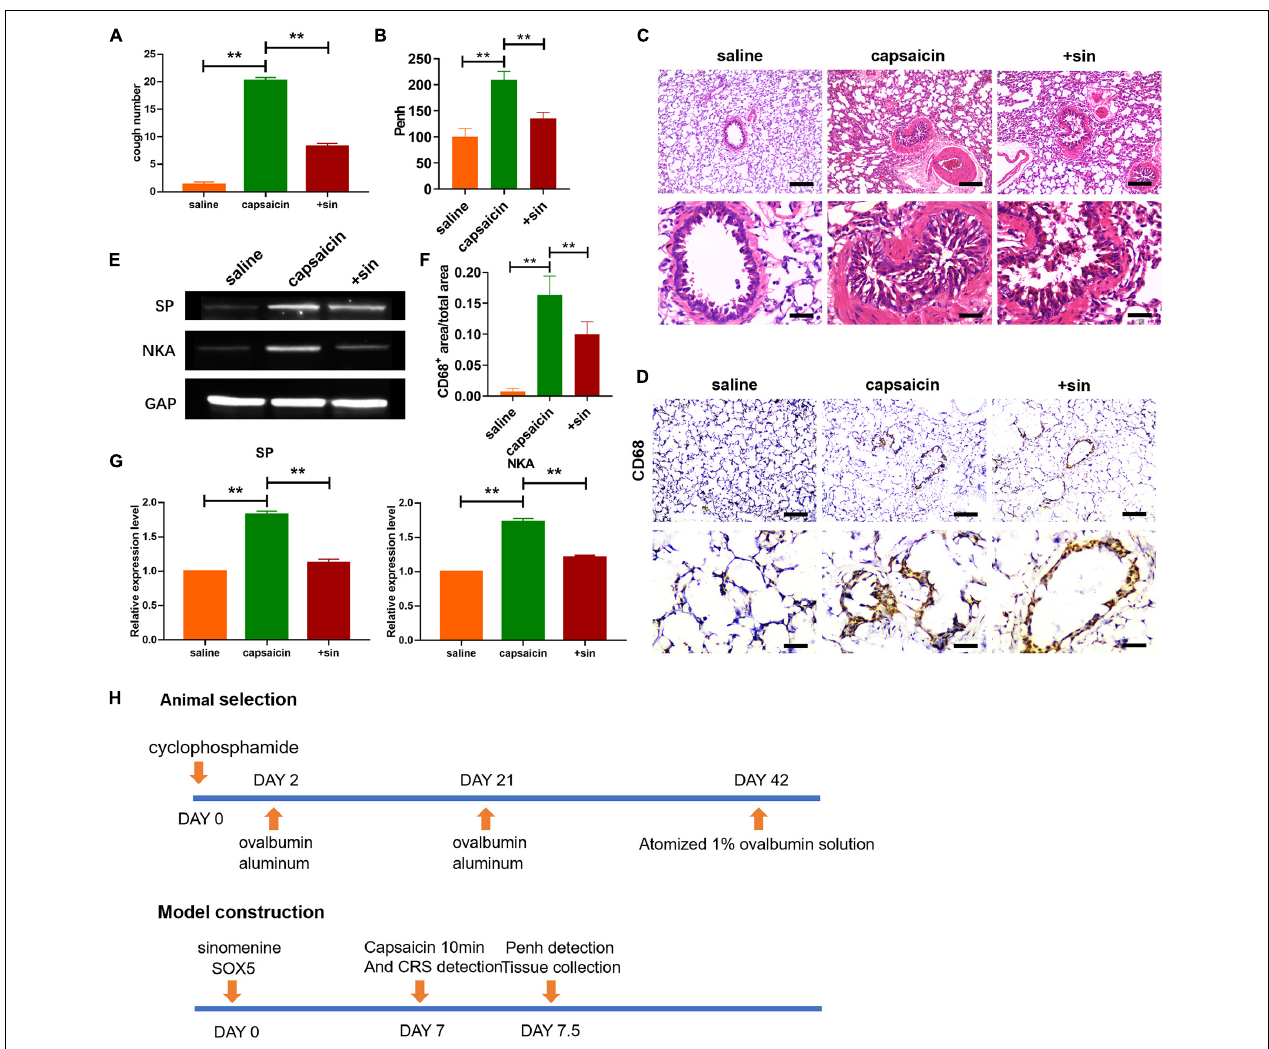
FIGURE 1 | Sinomenine treatment attenuated capsaicin-induced cough sensitivity in guinea pigs. (A) Cough reflex sensitivity (CRS) in guinea pigs. Sinomenine inhibited the cough induced by the capsaicin. Data are mean ± SEM; one-way ANOVA was used for the statistical analysis. (B) Sinomenine reduced the capsaicin-induced increase in Penh. Data are mean ± SEM; one-way ANOVA was used for the statistical analysis. (C) H&E staining of lung tissues showing the levels of infiltration by inflammatory cells. Scale bars represent 50 and 100 µ m. (D,F) CD68 staining of lung tissues from guinea pigs treated with saline, capsaicin, or sinomenine. Scale bars represent 50 and 100 µ m. (E,G) Western blot assay of the expression levels of SP and NKA in trachea and lung tissues of guinea pigs. Data are mean ± SEM; one-way ANOVA was used for the statistical analysis. (H) Scheme for the screening of guinea pigs and construction of cough model. ** P < 0.01; n =